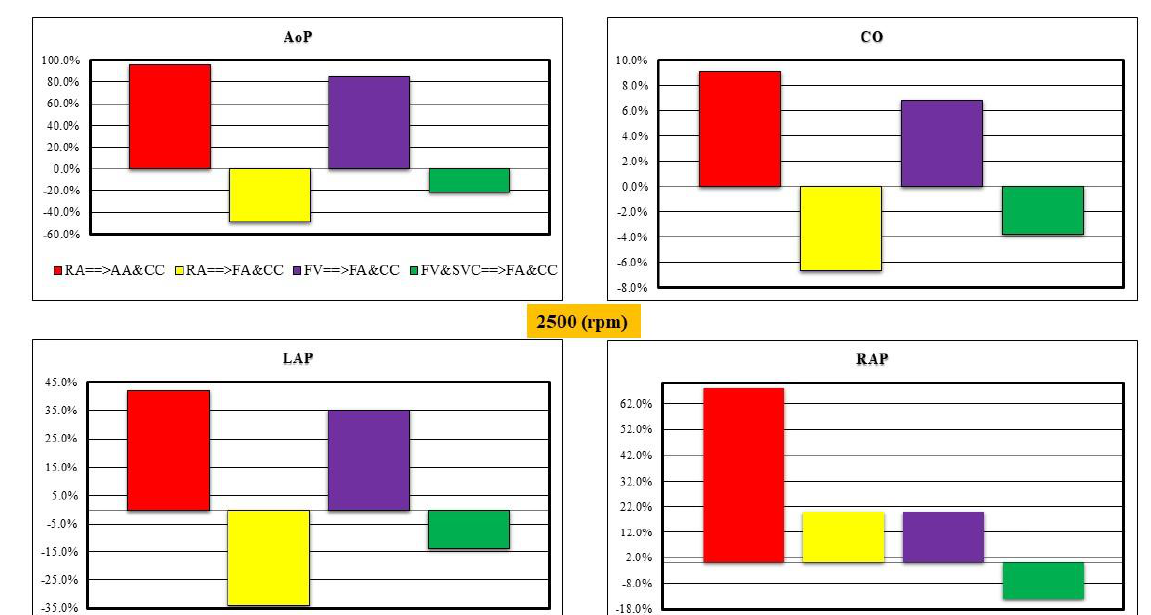
Figure 8. Relative changes calculated in comparison to baseline conditions for the four different methods of cannulation with pump rotational speed set to 2500 rpm. The top ( bottom ) -left panel shows the relative changes in the aortic pressure AoP (left atrial pressure). The top ( bottom ) -right panel shows the relative changes in the cardiac output CO (right atrial pressure).